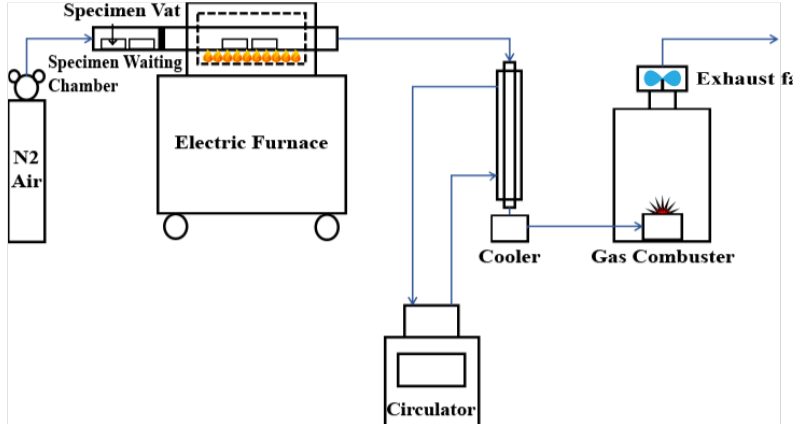
Figure 1. Configuration of the pyrolysis experiment setup.